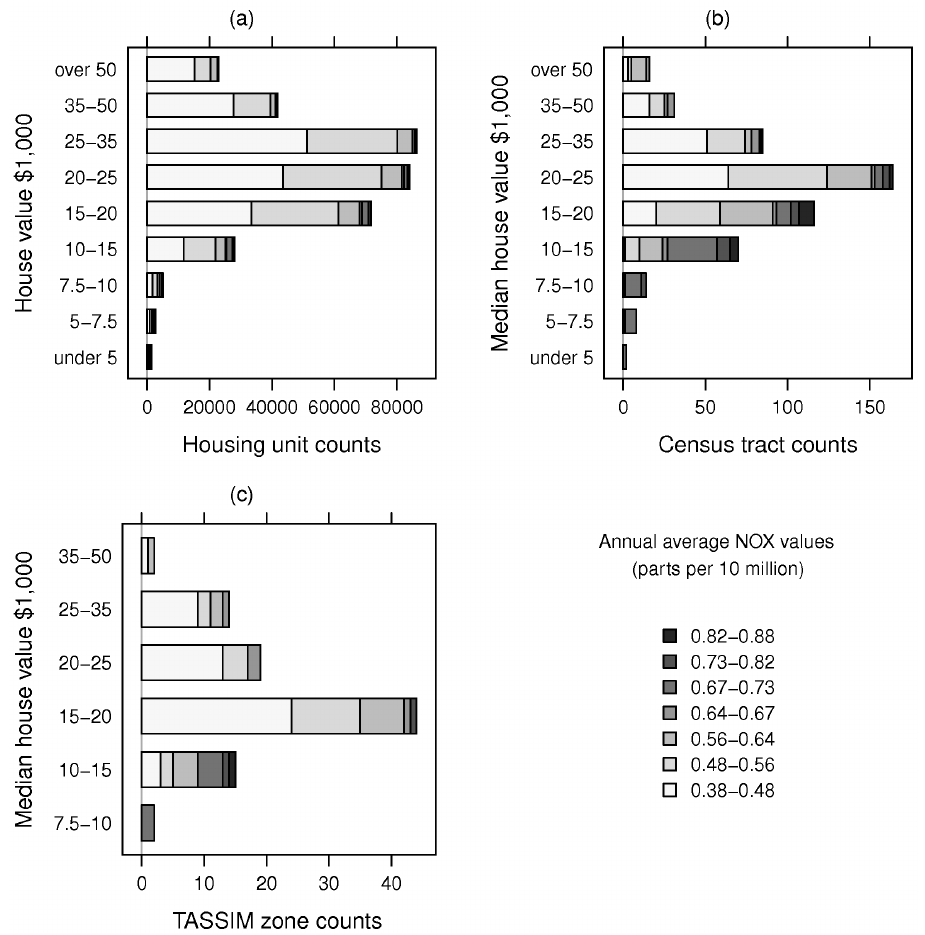
Figure 1: Bar charts by H11 classes (under 5, 5–7.5, 7.5–10, 10–15, 15–20, 20–25, 25–35, 35–50, over$50 thousand 1970) and seven natural breaks average annual NOX classes given in parts per 10 million (also used for fill colors) — (a): counts of housing units; (b): counts of census tracts by median house values; (c): counts of TASSIM zones by median house